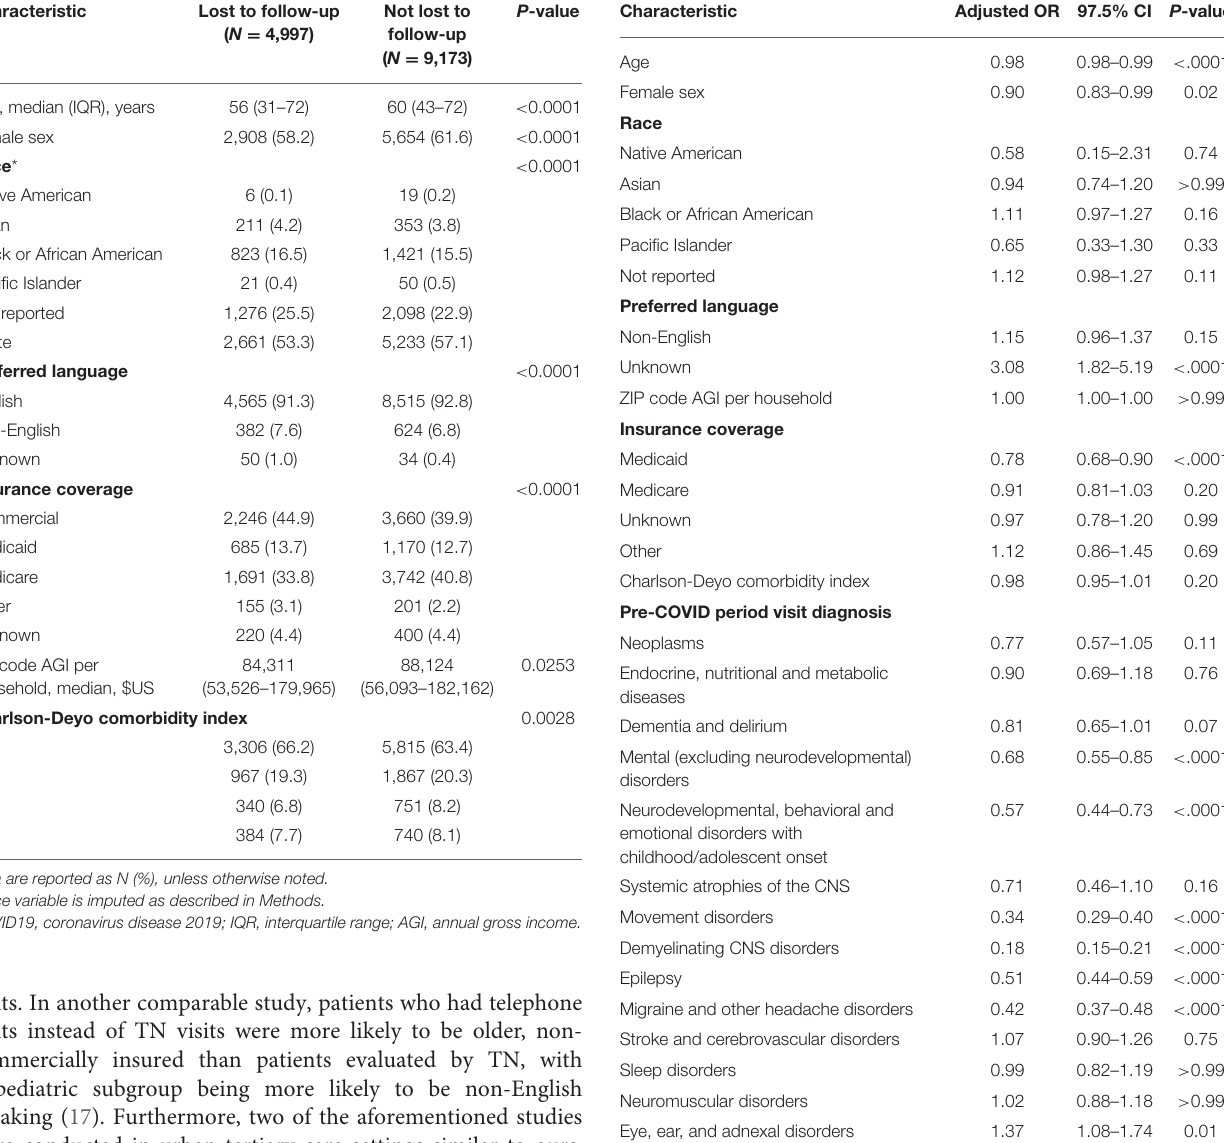
TABLE 5 | Multivariable analysis of patient characteristics associated with loss to follow-up during the COVID period. Not lost to ( N = 4,997) follow-up